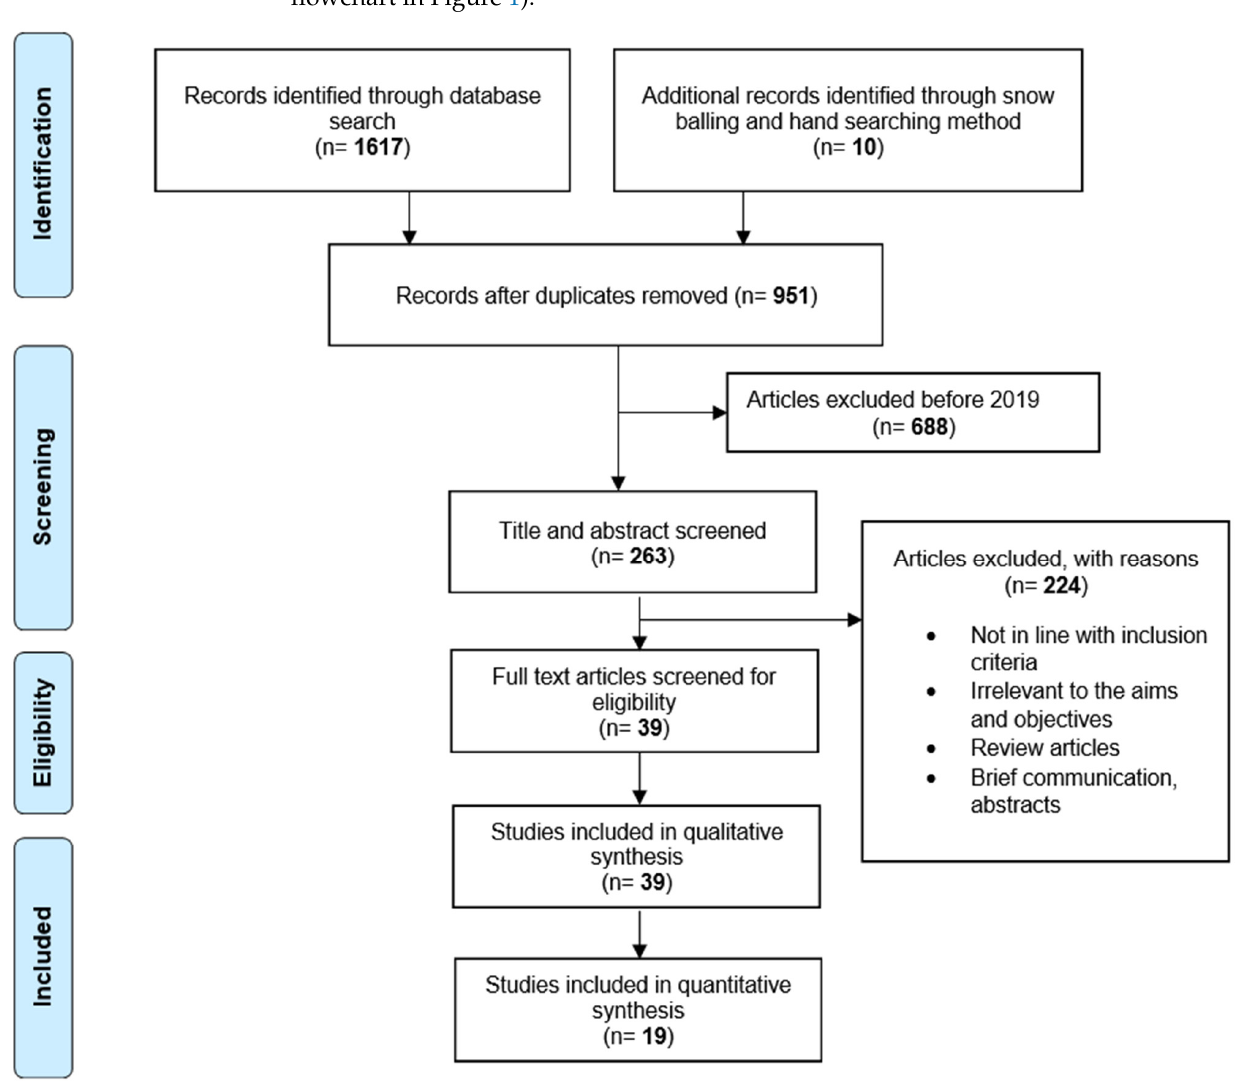
Figure 1. Included 19 studies (PRISMA flow